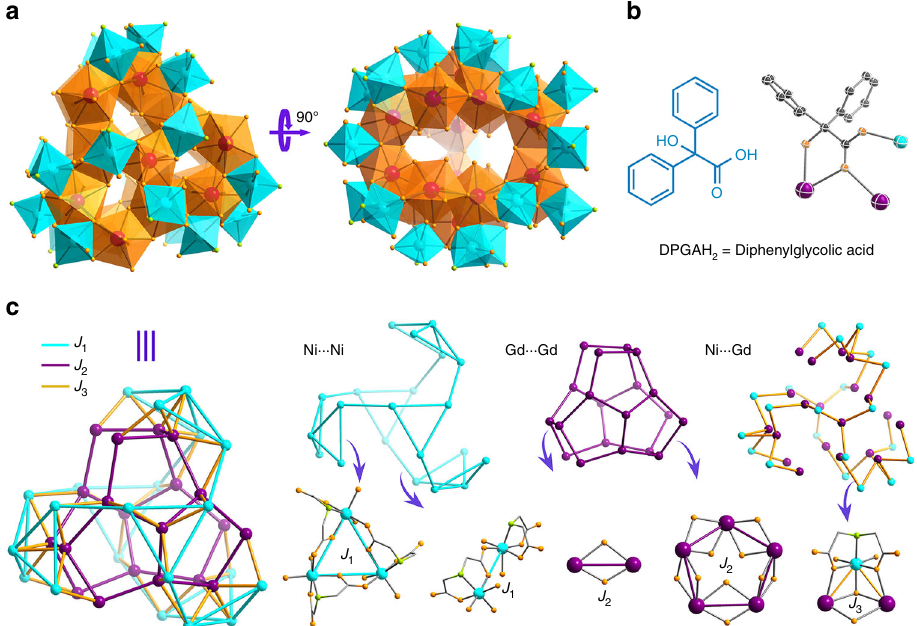
Fig. 1 The structure of nanocage {Ni 21 Gd 20 } determined by X-ray crystallography. a The polyhedron structures of {Ni 21 Gd 20 } core with the organic ligands removed for clarity; b The coordination mode of the DPGA 2 – ligand in this compound; c The magnetic coupling schemes of the metal centers in {Ni 21 Gd 20 } core. J 1 = Ni ∙∙∙ Ni, J 2 = Gd ∙∙∙ Gd, J 3 = Ni ∙∙∙ Gd; Color codes: Gd purple, Ni cyan, N green, O orange, C